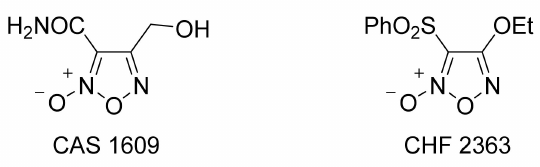
Figure 4. Structures of CAS 1609 and CHF